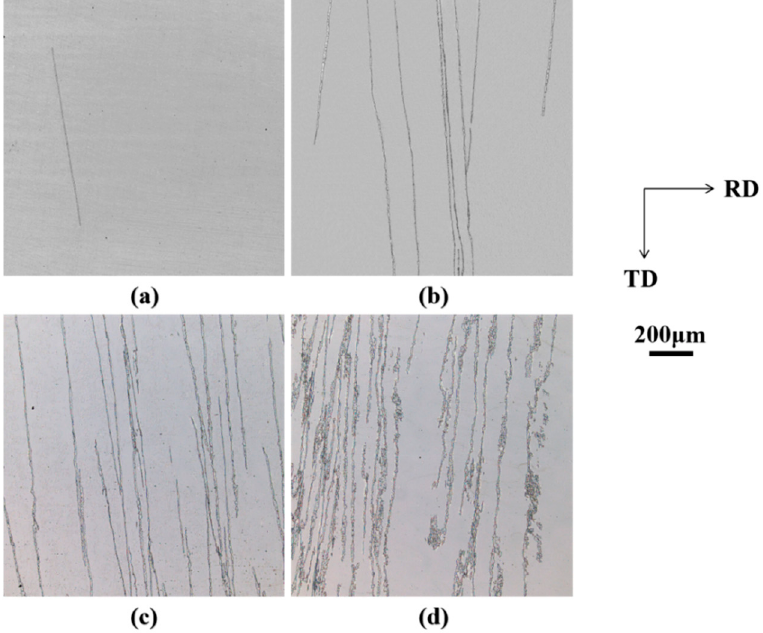
Figure 4. The morphology of deformation twinning within Goss-oriented grains at different reductions in rolling plane. ( a ) 32%; ( b ) 41%; ( c ) 53%; ( d ) 78% reduction.